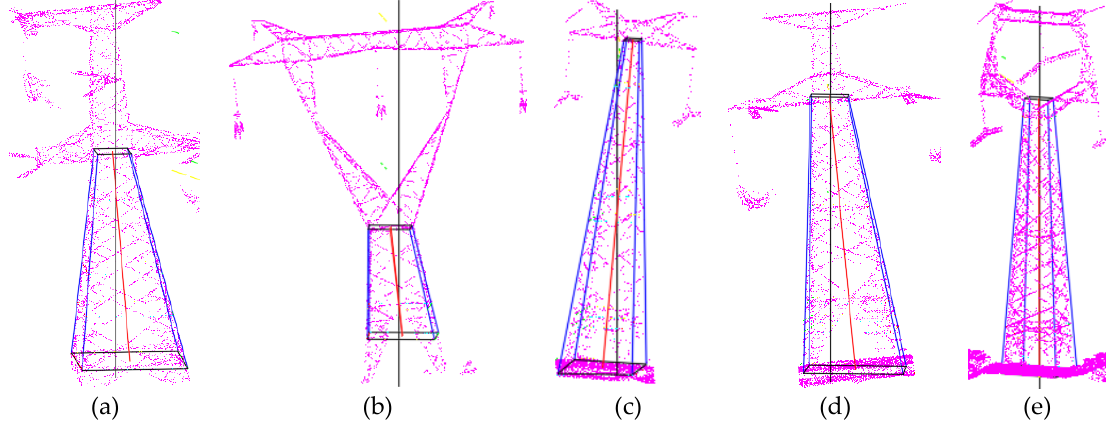
Figure 12. Central axis calculation result of typical towers. ( a – e ) represents five typical types structure of towers. The tilt of 60 transmission towers was calculated, and the rotation angles of each transmission tower without manual tilt, 5 degrees rotation around X axis, 5 degrees rota- tion around Y axis, 5 degrees rotation around Y axis, 10 degrees rotation around X axis, 10 degrees rotation around Y axis, 10 degrees rotation around Y axis and 10 degrees rotation around Y axis and the corresponding precision were calculated. The calculation results of 18 transmission towers of six types were randomly selected for analysis, as shown in Table 4. The calculation of transmission tower tilt angle was accurate, and the relative error was better than 0.7 ◦ . Table 4. Calculation accuracy of tower tilt 1 .